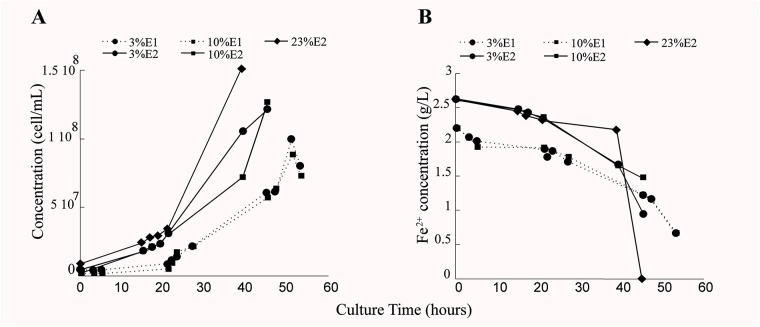
Cell growth (cell/mL) (A) and ferrous consumption (g/L) (B) of Leptospirillum ferriphilum DSM 14647 under the analyzed conditions (3, 10, and 23% of inlet-O2). The dotted and continuous lines are showing the results of the experimental repetitions E1 and E2, respectively.